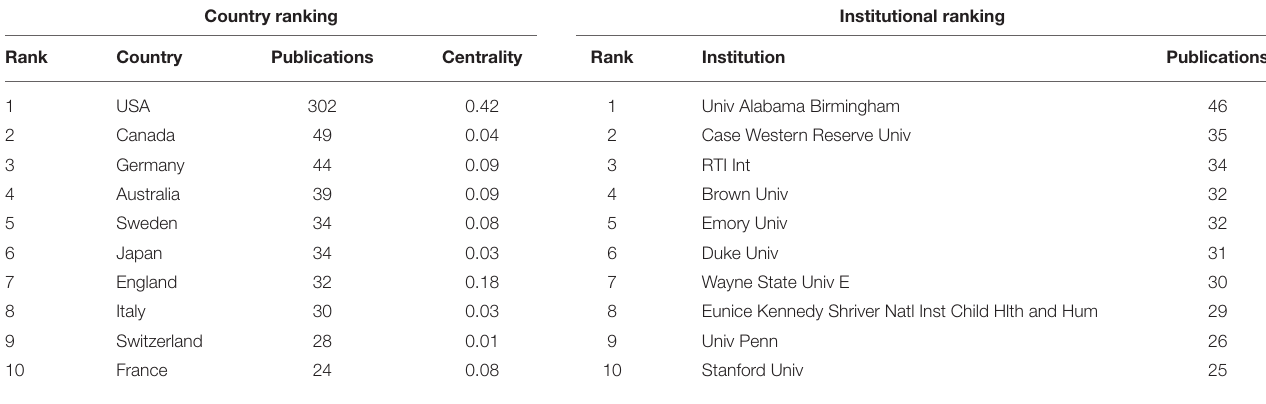
TABLE 1 | Top 10 countries and institutes publishing research on BPD in extremely pre-mature